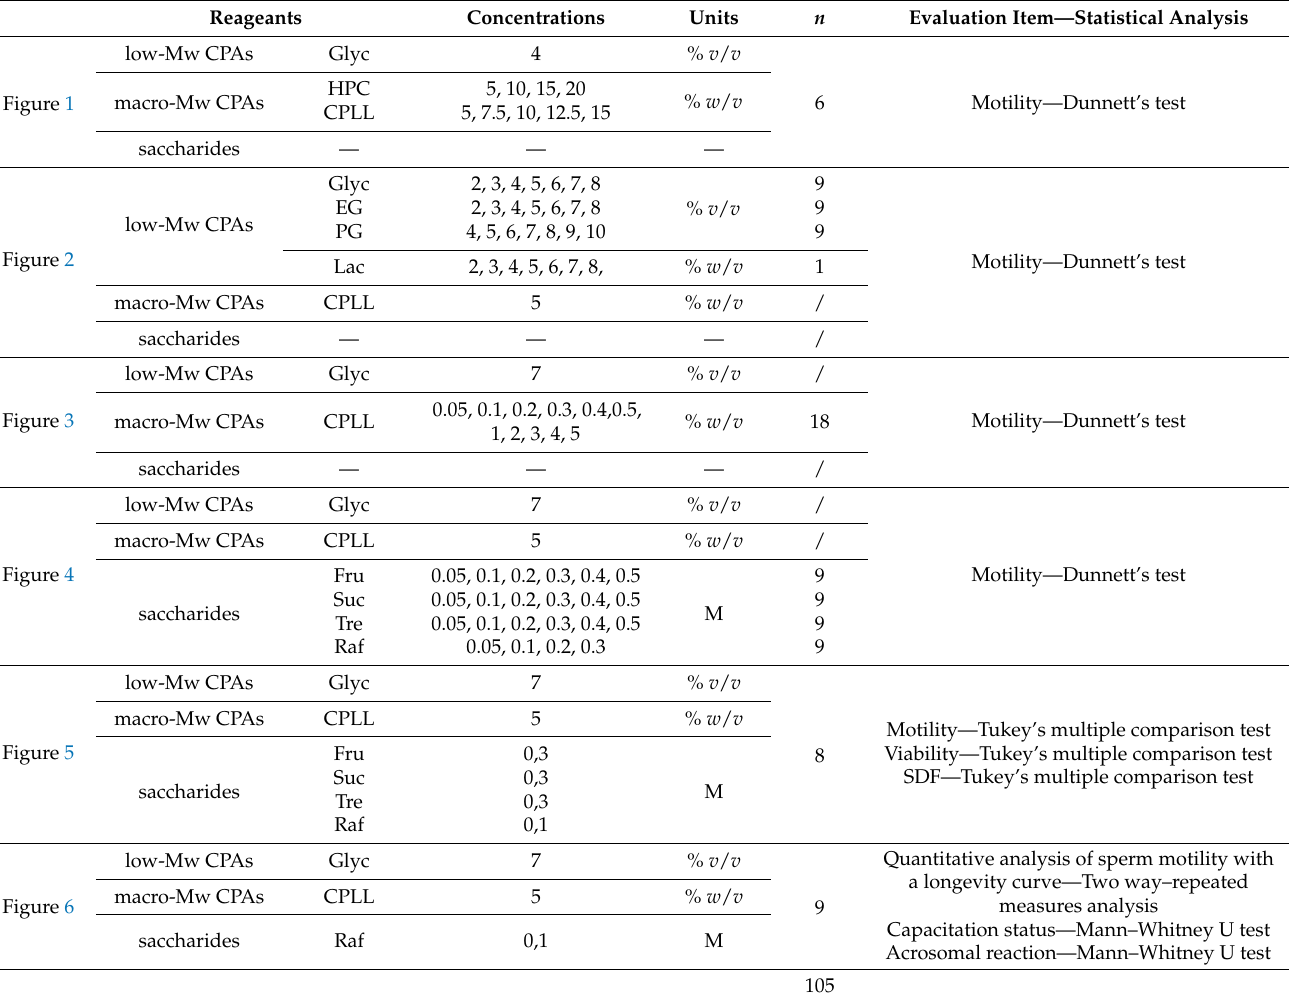
Table 1. Concentrations used in each experiment, number of samples, and analysis method.